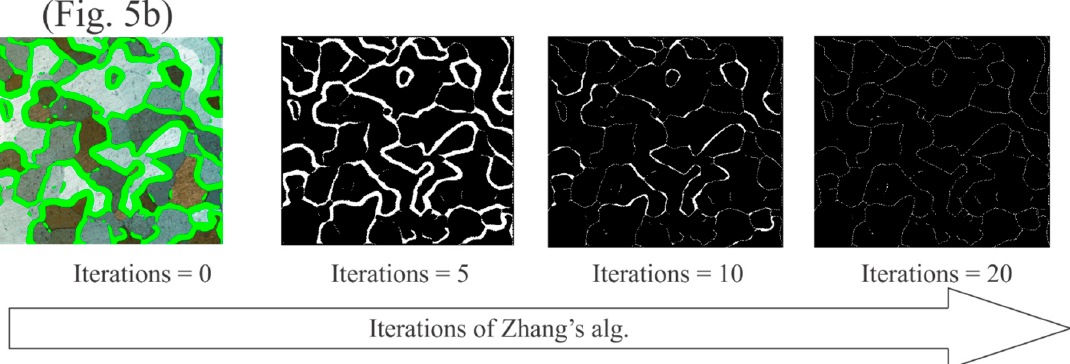
Figure 6. Zhang’s thinning algorithm used to compute binary edge images.